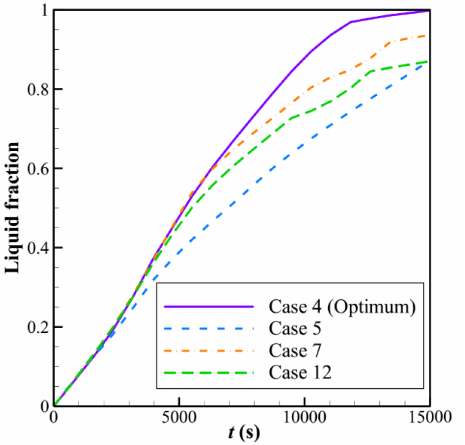
Figure 5. The melting behaviors of the LHTES unit during the time for five selected cases.